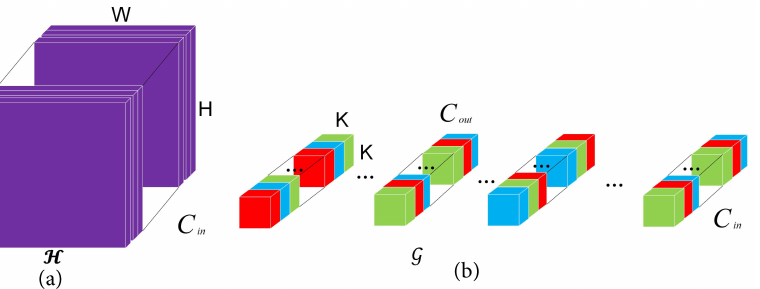
Figure 4. Schematic diagram of the structure of PSconv. ( a ) the input features; ( b ) the different expansion factors added to the convolution